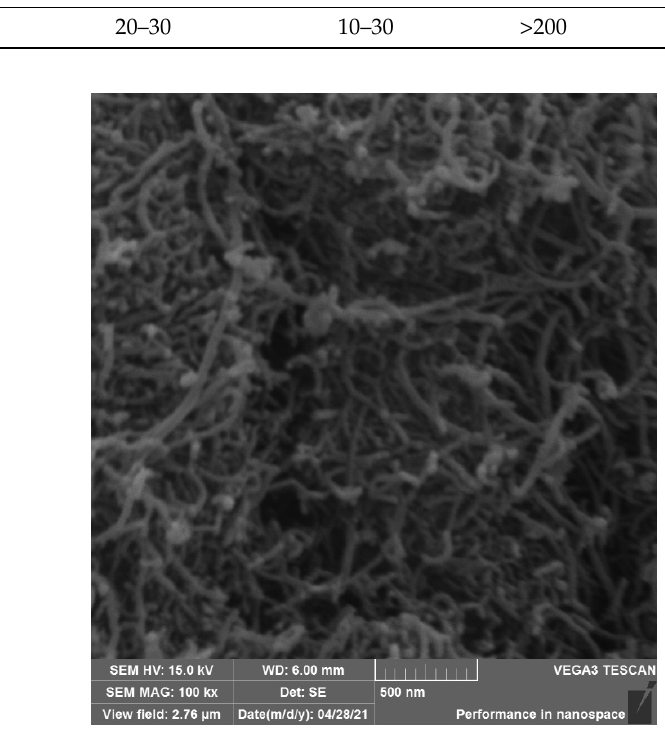
Figure 1. SEM image of CNTs at 100,000×